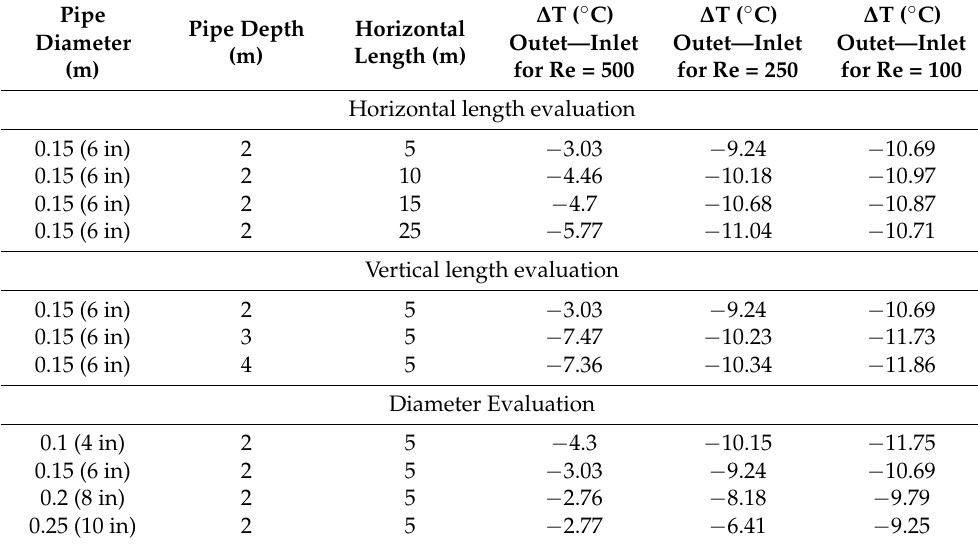
Table 10. Numerical evaluation of the cooling potential according to the dimensions of the GAHE. Pipe